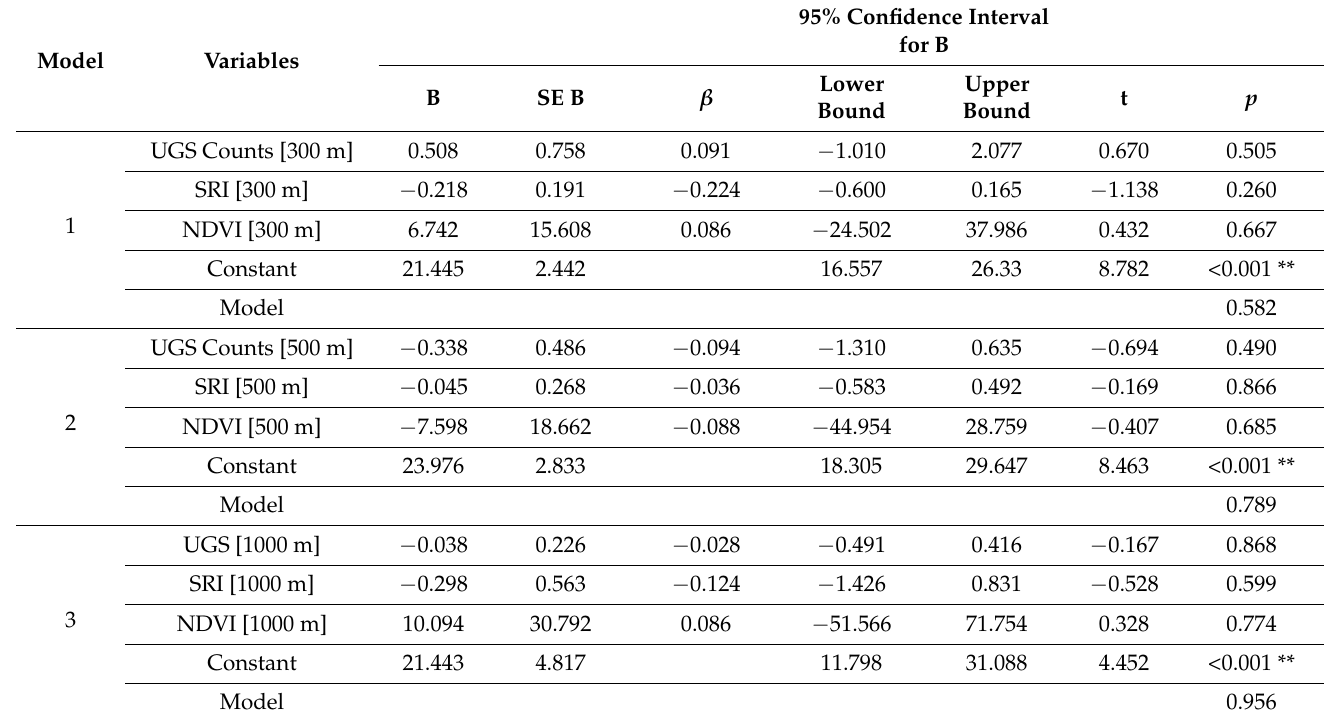
Table 3. The results of the multiple linear regression model for body mass index considering the urban green space, normalized difference vegetation index and species richness index values for the sample without